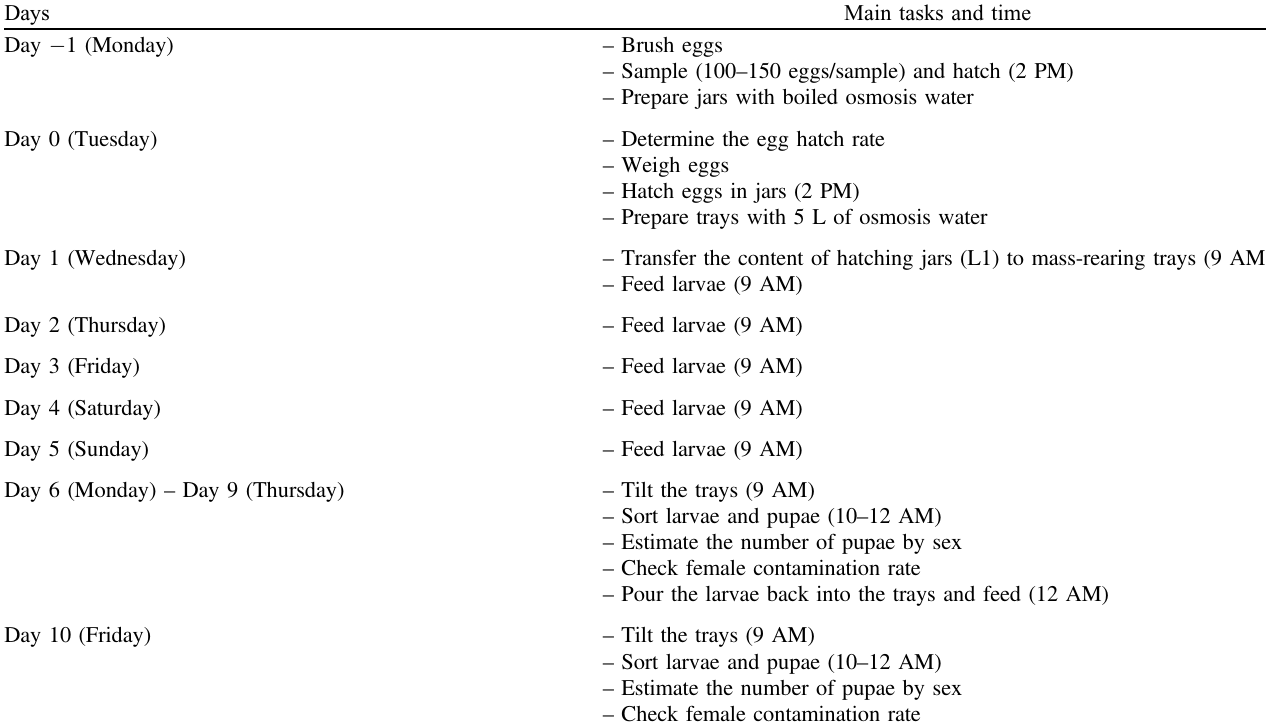
Table 1. Rearing schedule with the main tasks and time used in this experiment. Days Main tasks and